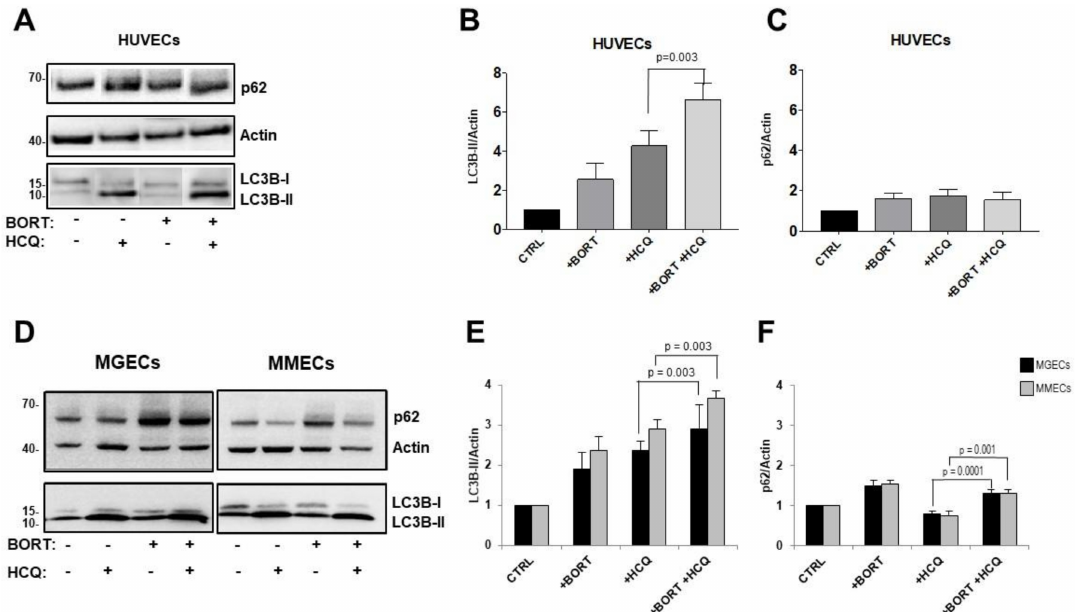
Figure 4. Bortezomib and hydroxychloroquine combination upregulates autophagosome formation in endothelial cells (ECs). ( A ) Human uMbilical vein endothelial cells (HUVECs), ( D ) ECs from monoclonal gammopathy of undetermined significance (MGECs, n = 9) and ECs from multiple myeloma (MMECs, n = 11) were treated with or without bortezomib (10 nM), HCQ (100 uM), or with both drugs for 24 h, followed by immunoblotting to determine LC3B-II and p62 levels under each condition. ( B – F ) Densitometric analysis of HUVEC ( B , C ), MGEC (black bars), and MMEC (gray bars) ( E , F ) lysates for LC3B-II ( B , E ) and p62 ( C , F ) expression. The results are expressed as fold-change normalized to the β -actin level and relative to the control. Mann–Whitney U